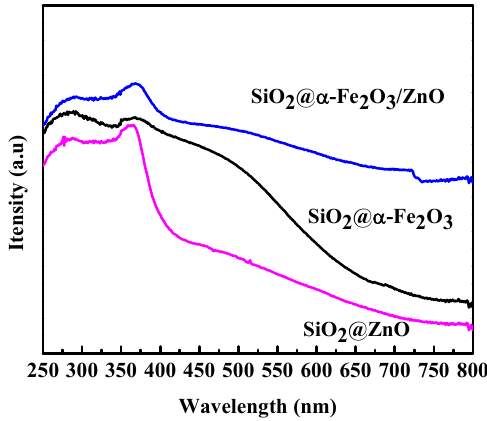
Figure 4. UV–vis spectra of SiO 2 @ZnO, SiO 2 @ α -Fe 2 O 3 and SiO 2 @ α -Fe 2 O 3 /ZnO nanocomposites.